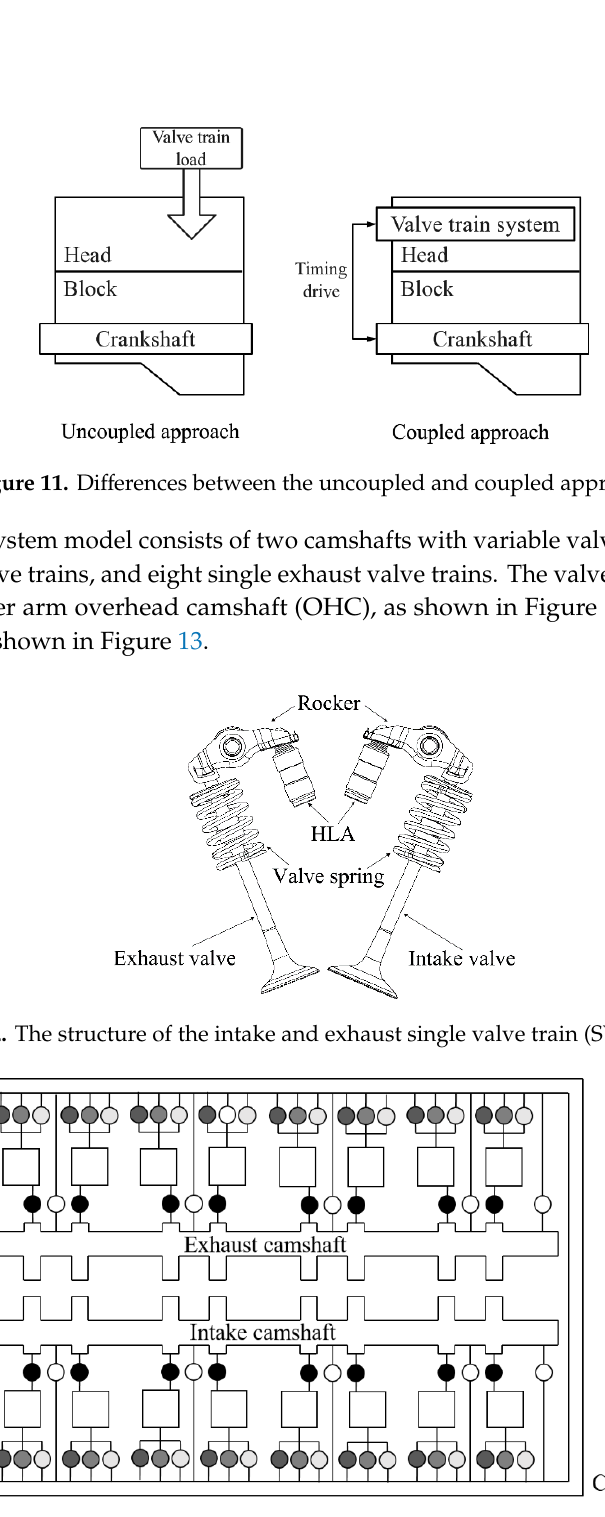
Figure 13. The topology of the valve train system.